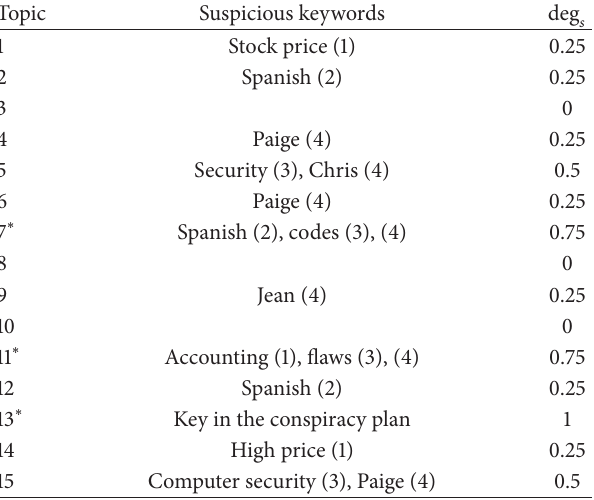
Table 4: The suspicion degree of topics.